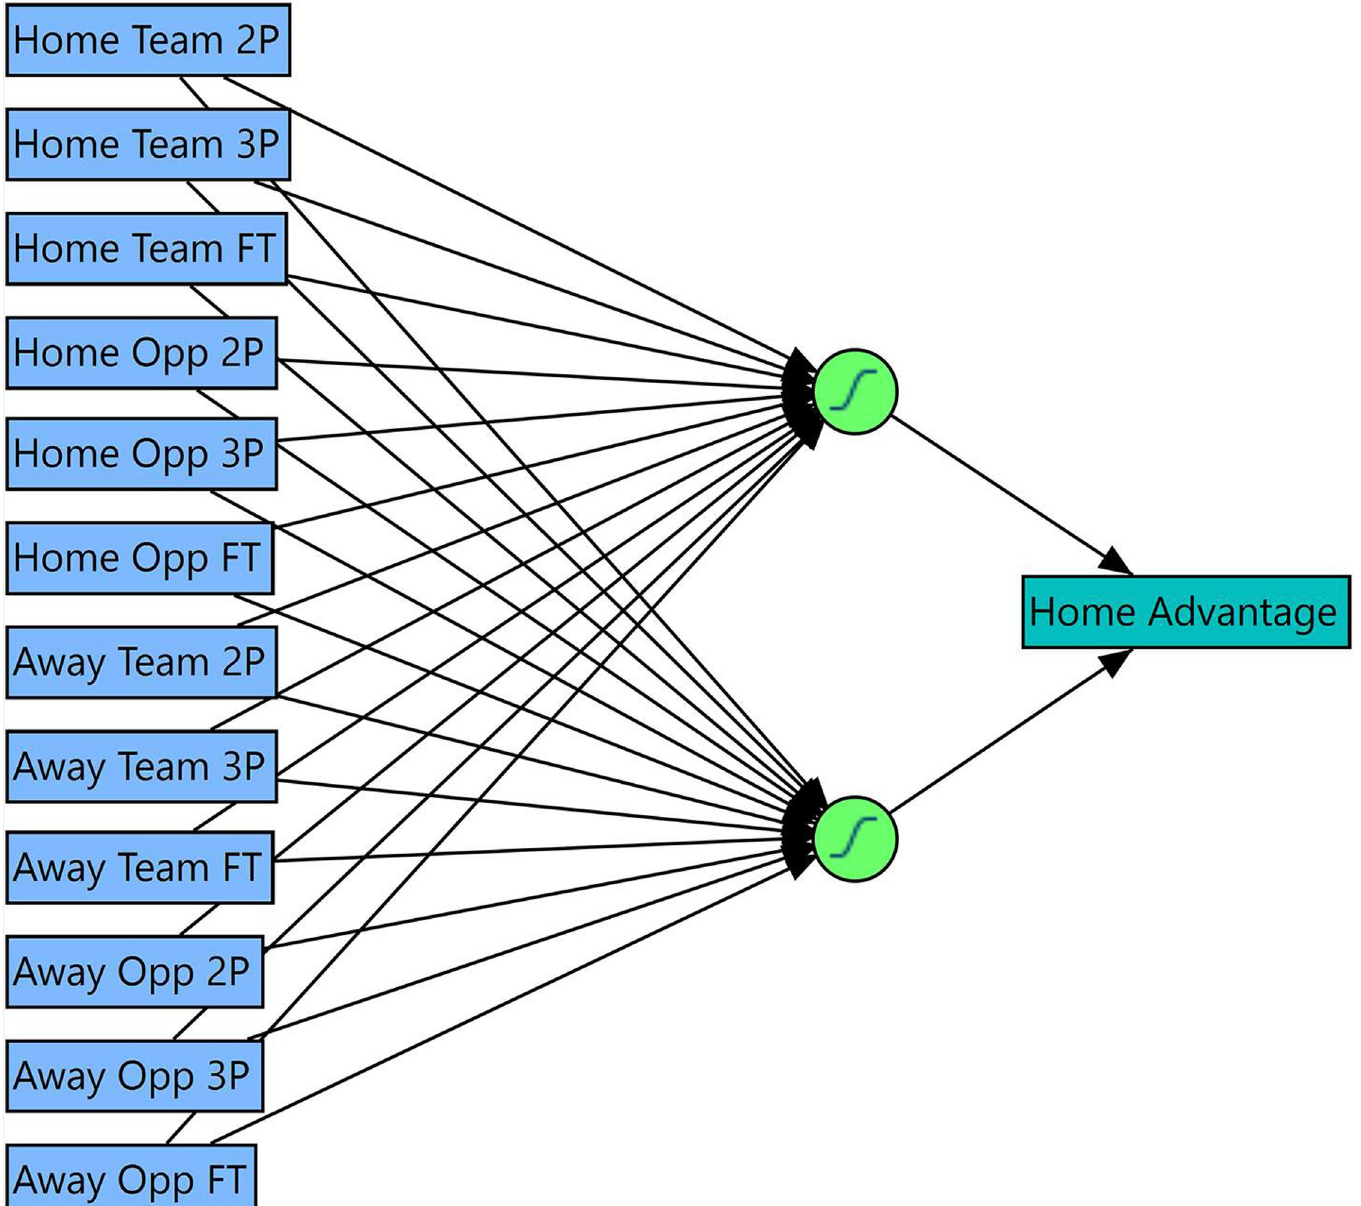
Fig 1. ANN schematic. A schematic showing the 12 best performing inputs (blue), the ideal number of nodes (green), and the diagnosed home advantage (teal).